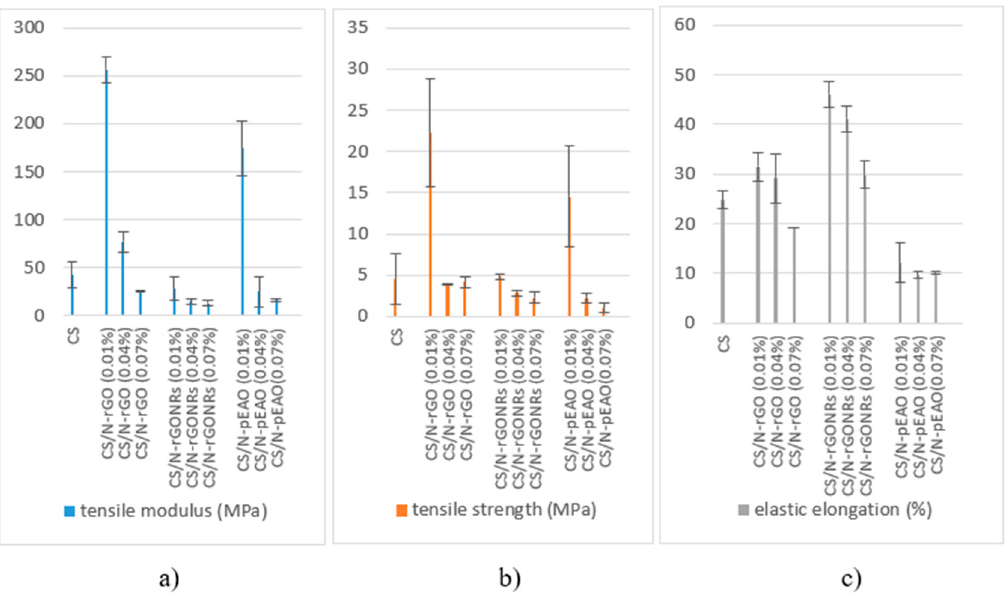
Figure 8. ( a ) Tensile modulus (MPa), ( b ) Tensile strength (MPa) and ( c ) Elastic elongation (%) data obtained at tensile testing of neat CS and CS/graphene composite membranes, containing 0.01%, 0.04%, and 0.07% of N ‐ rGO, N ‐ rGONRs and N ‐ pEAO.